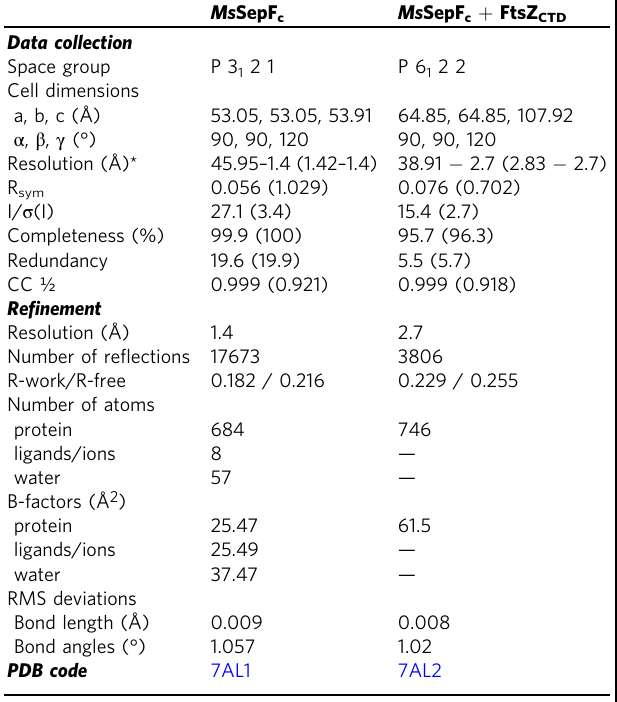
Table 1 Crystallographic